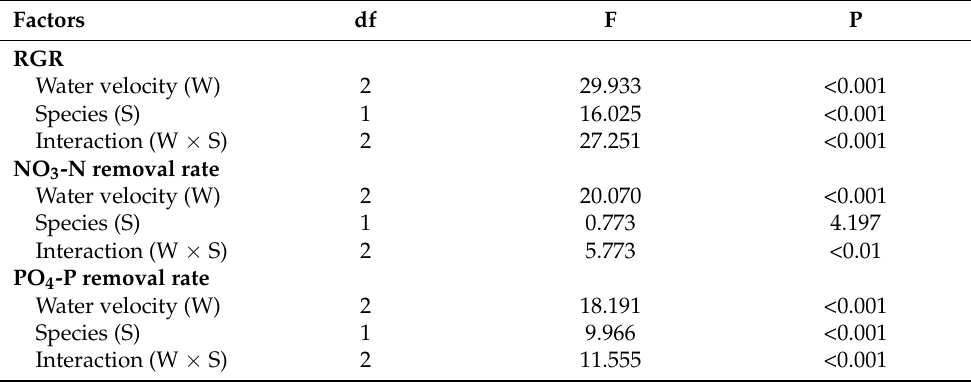
Figure 2. The RGRs and NO 3 -N and PO 4 -P removal rates of N. haitanensis and N. dentata cultured for 4 days under three water velocities. Different capital and small letters indicate statistical significance ( P < 0.05) among species and water velocities, respectively. The data represent the mean ± SE (n = 3 replicates). Table 2. Analysis of variance (two-way ANOVA) examining the effects of the water velocity on the RGR and NO 3 -N and PO 4 -P removal rates of N. haitanensis and N. dentata , and the comparison of these parameters between the two